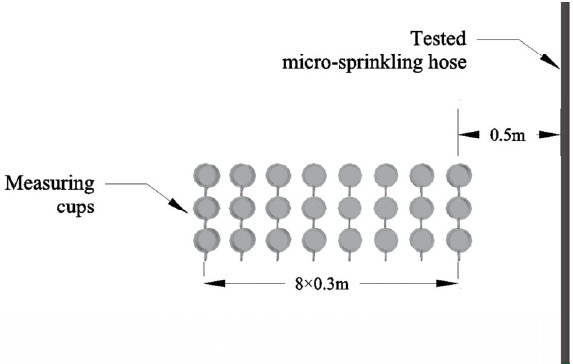
Figure 3. Sampling area and measuring cup layout. Sampling areas were set at the head (3 m), middle (20 m), and end (37 m) of the transverse direction. Measuring cups in the three sampling areas were arranged in the same way. The figure shows the arrangement of measuring cups in a sampling area.